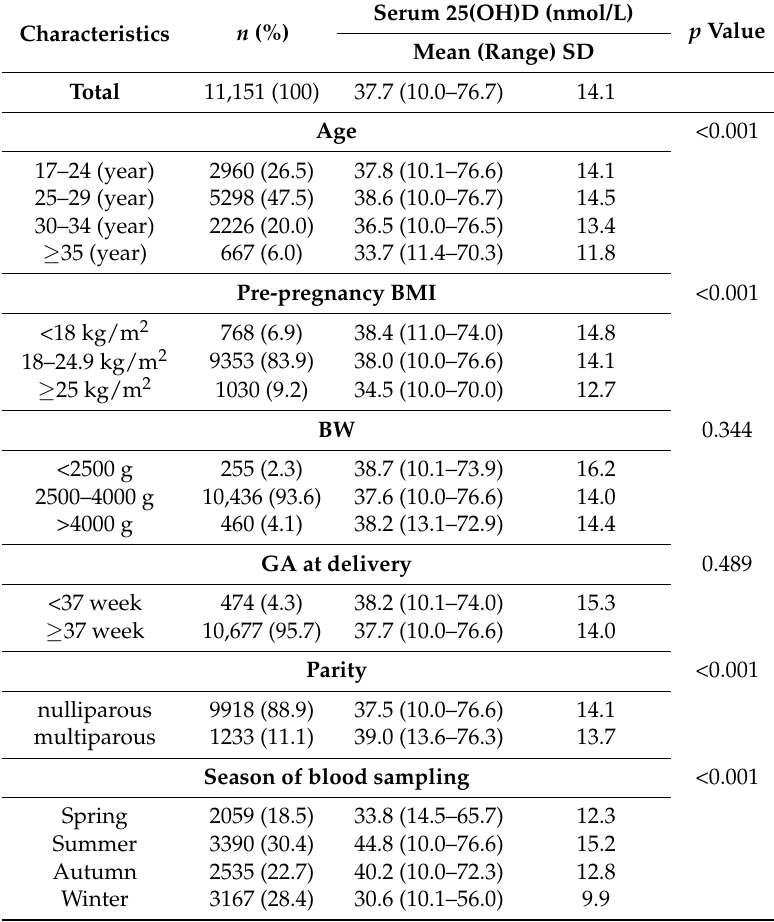
Table 1. The serum 25(OH)D concentration of pregnant women stratified by different